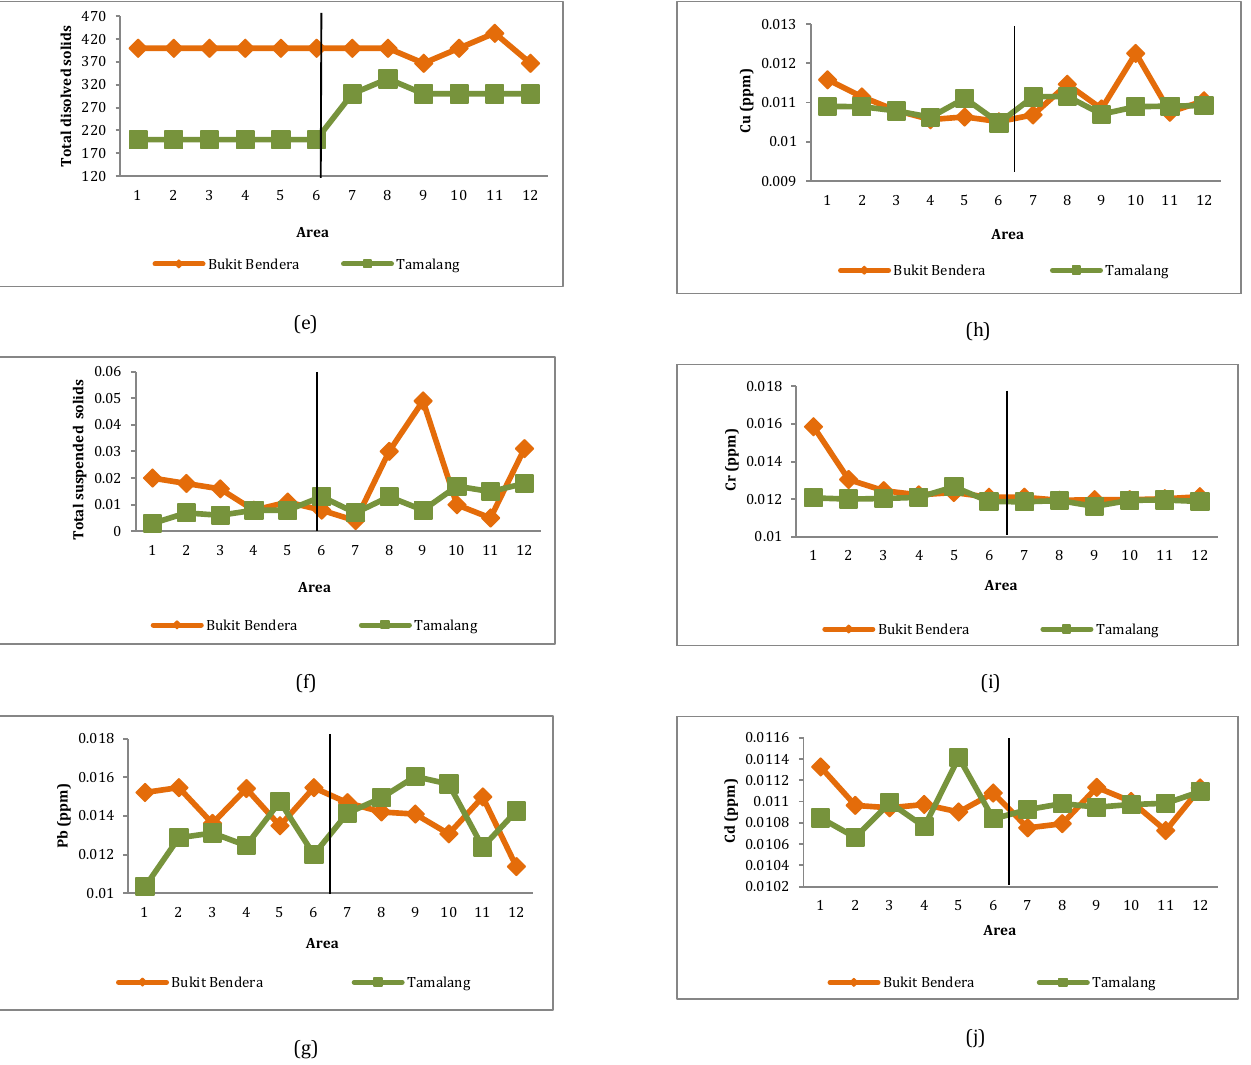
Figure 1: The trends of parameters concentration from the two different areas; hill (1- 6) to the villager’s houses (7 -12) for Bukit Bendera and Tamalang village, Kota Belud, Sabah; a) pH value b) Turbidity c)Temperature d) BOD e) Total dissolved solids f) Total suspended solids g) Pb h) Cu i) Cr and j) Cd. Table 3: The ANOVA Two Way for spring-water at Bukit Bendera village, Kota